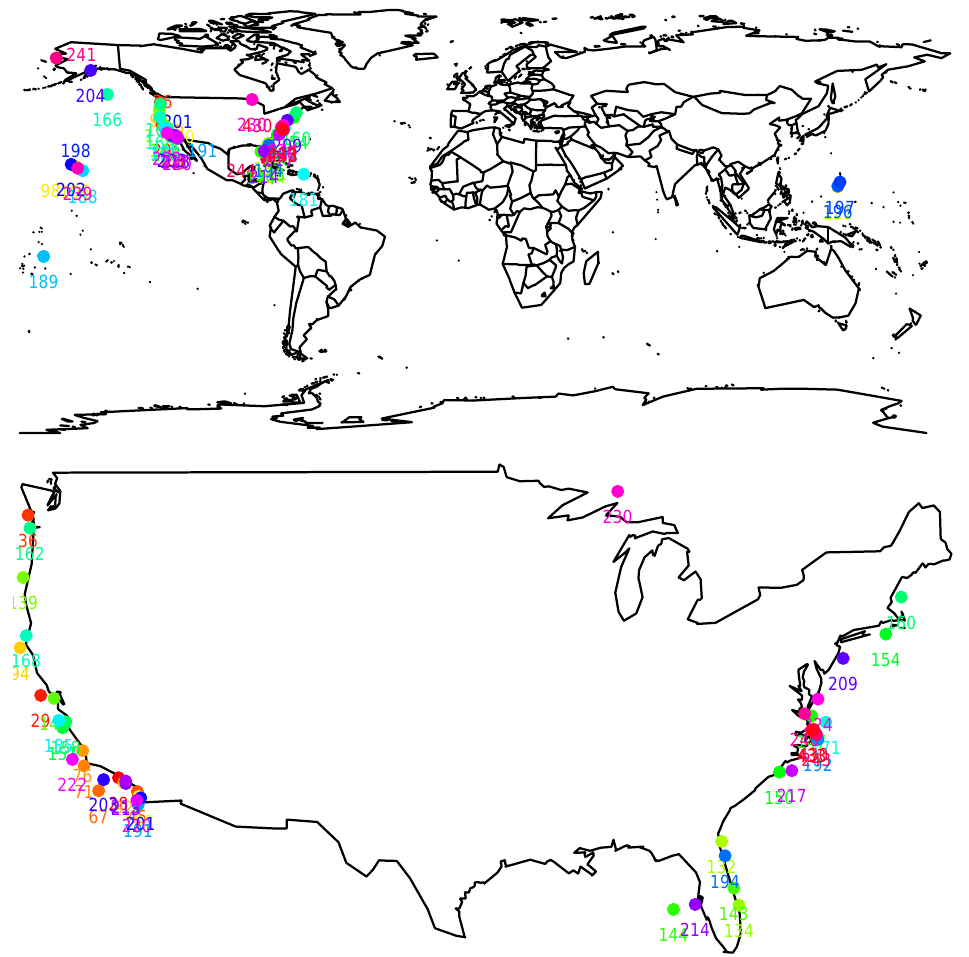
Figure 1. Top panel : World map with the coordinates of the 59 buoys whose measurements constitute the datasets analyzed in this paper. Bottom panel : Zoom of the top panel that shows the US mainland with the coordinates of the buoys close to it. The identification number is that in Table